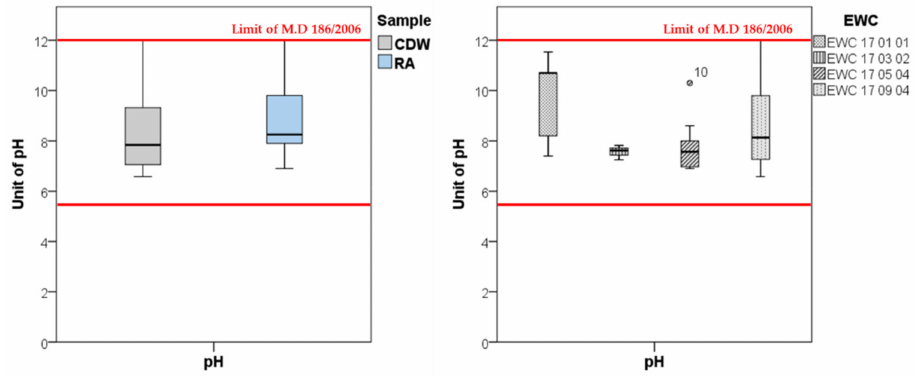
Figure 5. pH values of CDWs and RAs ( left ) and pH values of different EWC codes ( right ). As previously stated, total chromium is one of the most conflictive elements for CDW recovery and RA use. As shown in Figure 6, the greatest criticality was found in RAs as part of the samples analysed (i.e., upper whisker) show total chromium concentrations higher than the regulatory limit of 50 µ g/L. From the analysis developed, the main source of chromium are cementitious materials (EWC 170101), in which 50% of the total concen- trations are close to the regulatory limit. This is mainly due to the presence of Portland cement [41] and the mortar adhered to the original natural aggregate [21].